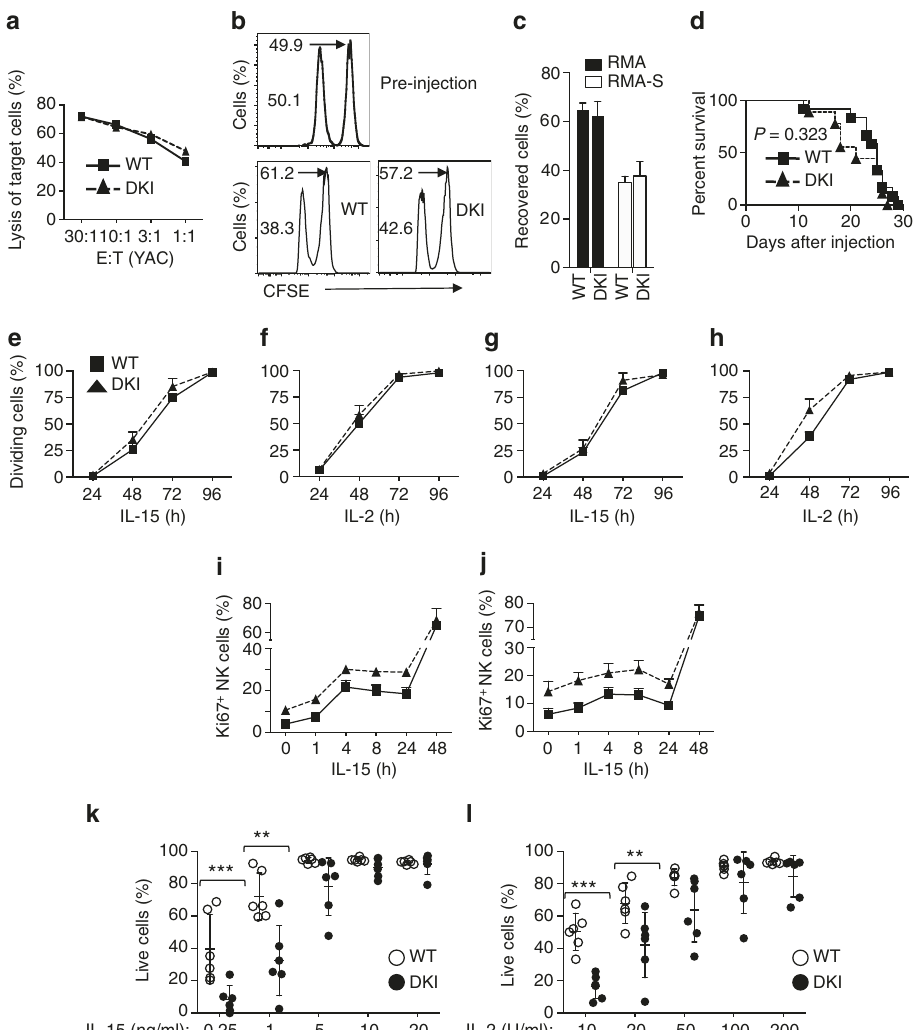
Fig. 3 Stat5 DKI NK cells have normal NK cytotoxicity and proliferative responses but defective survival in response to IL-2 and IL-15 stimulation. a Representative line graph showing the percentage of 51 Cr-labelled YAC-1 cell lysis by WT (black squares and black lines) and Stat5 DKI (black triangles and dashed lines) NK cells. NK cells were isolated from three WT and Stat5 DKI mice. The experiment was performed twice. b Representative histograms showing percentage of CFSE-labelled RMA-S ( fi rst (left) peaks) and CFSE-labelled RMA (second (right) peaks) cells pre-injection or 16 h after intraperitoneal injection into WT and Stat5 DKI mice. The numbers indicate the percentage of RMA-S and RMA cells recovered. c Summary of two independent experiments. d Kaplan − Meier curves showing similar RMA-S tumour rejection in WT ( n = 12, solid squares with line) and Stat5 DKI ( n = 9, solid triangles with dotted line) mice. The data are derived from three independent experiments and the p -value (Mantel-Cox test) is shown. Black squares and solid lines indicate WT cells and black triangles and dotted lines indicate Stat5 DKI cells. e Time course of proliferative responses of WT and Stat5 DKI bone marrow NK cells in response to 20 ng ml − 1 IL-15. Black squares and solid lines indicate WT cells and black triangles and dotted lines indicate Stat5 DKI cells. f Time course of proliferative responses of WT and Stat5 DKI bone marrow NK cells in response to 1000 U ml − 1 IL-2. Black squares and solid lines indicate WT cells and black triangles and dotted lines indicate Stat5 DKI cells. g Time course of proliferative responses of WT and Stat5 DKI splenic NK cells in response to 20 ng ml − 1 IL-15. Black squares and solid lines indicate WT cells and black triangles and dotted lines indicate Stat5 DKI cells. h Time course of proliferative responses of WT and Stat5 DKI splenic NK cells in response to 1000 U ml − 1 IL-2. Black squares and solid lines indicate WT cells and black triangles and dotted lines indicate Stat5 DKI cells. i Line graphs of Ki67 staining of WT and DKI bone marrow NK cells stimulated with 20 ng ml − 1 of IL-15 for 0, 1, 4, 8, 24 and 48 h, as indicated. Black squares and solid lines indicate WT cells and black triangles and dotted lines indicate Stat5 DKI cells. j Line graphs of Ki67 staining of WT and DKI splenic NK cells stimulated with 20 ng ml − 1 of IL-15 for 0, 1, 4, 8, 24 and 48 h, as indicated. Black squares and solid lines indicate WT cells and black triangles and dotted lines indicate Stat5 DKI cells. ( k and l ) Dose response of WT (open circles) and Stat5 DKI ( fi lled circles) splenic NK cells to IL-15 ( k ) or IL-2 ( l ) stimulation on day 4. The percentages of live cells were determined using live/dead cell assay kit and fl ow cytometry cell counting beads. Error bars in c and e − l are means ± SEM and statistical analyses were performed by grouped multiple t -test using Prism